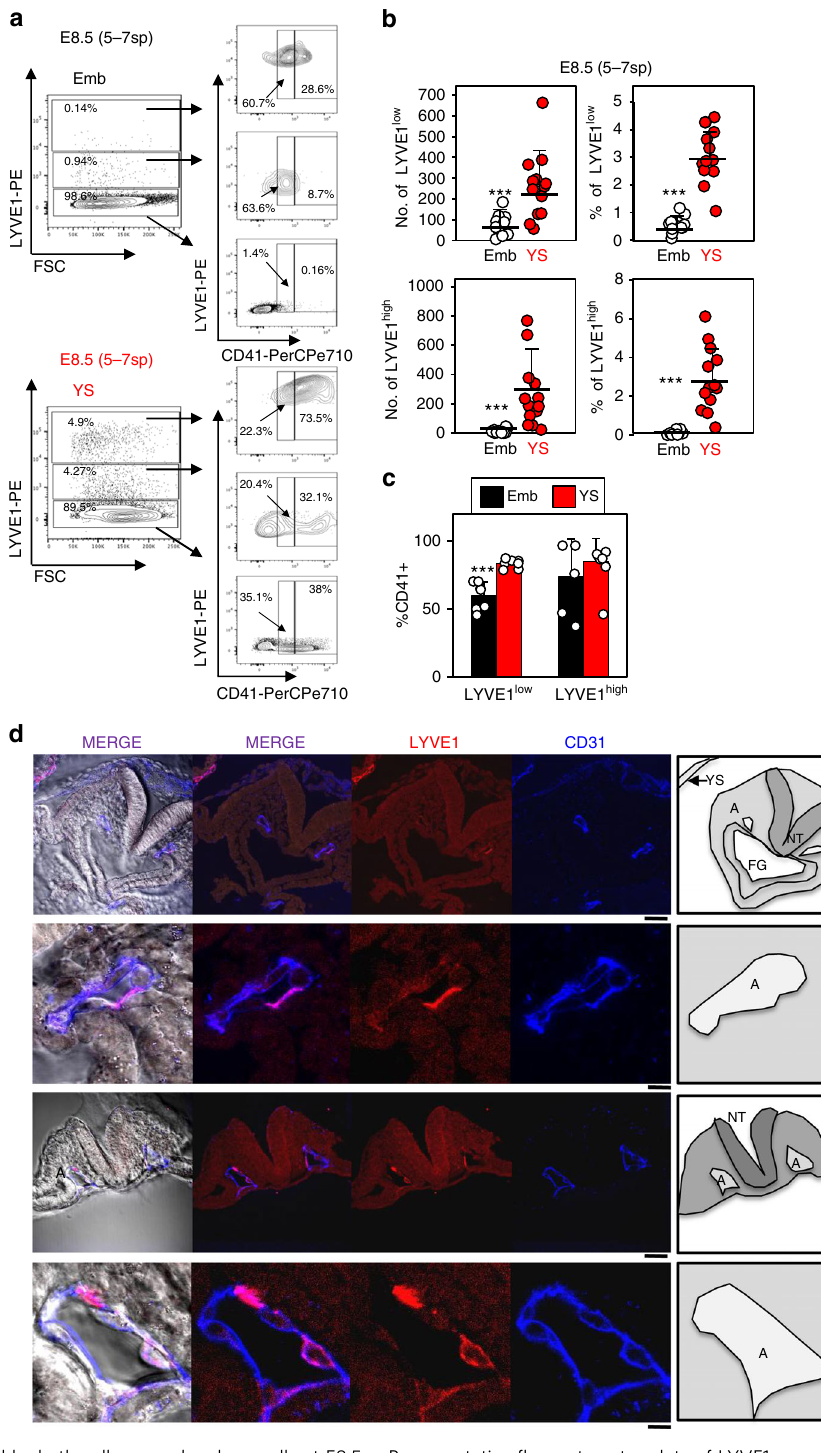
Fig. 6 LYVE1 is expressed by both yolk sac and embryo cells at E8.5. a Representative fl ow cytometry plots of LYVE1 expression in freshly isolated E8.5 (5 – 7sp) embryos and YS. b Cell surface expression of LYVE1 in YS and embryos dissected from freshly isolated E8.5 (5 – 7sp) concepti ( n = 16). The absolute number per concepti and frequency as a percent of total live events of LYVE1 low and LYVE high cells is shown. Each circle represents an independent YS or embryo. c Frequency of CD41 + cells as a percent of total live events of LYVE1 low and LYVE high cells is shown ( n = 16) for embryos and YS. a – c Two independent litters were analyzed. (*** p < 0.001, two-sample t-test for LYVE1 low and eWrs-test LYVE high ; differences held even after multiple testing corrections to control a FDR of 0.05). Means are shown. Error bars denote standard deviation. d Representative confocal images showing the pattern of expression of LYVE1 in E8.5 embryos and YS. Two independent embryos are shown. For each representative embryo an inset zoomed on one of the paired aortas is also shown. Anti-LYVE1 conjugated to CF TM 568 is shown in red and anti-CD31 − BV421 is shown in blue. Scale bars stand for 50 µ m for the low magni fi cation (i and iii) and 10 µ m for the high magni fi cation (ii and iv). Schematics indicate anatomical parts: FG: foregut; A: paired- aorta; NT: Neural tube. Source data are provided as a Source Data fi